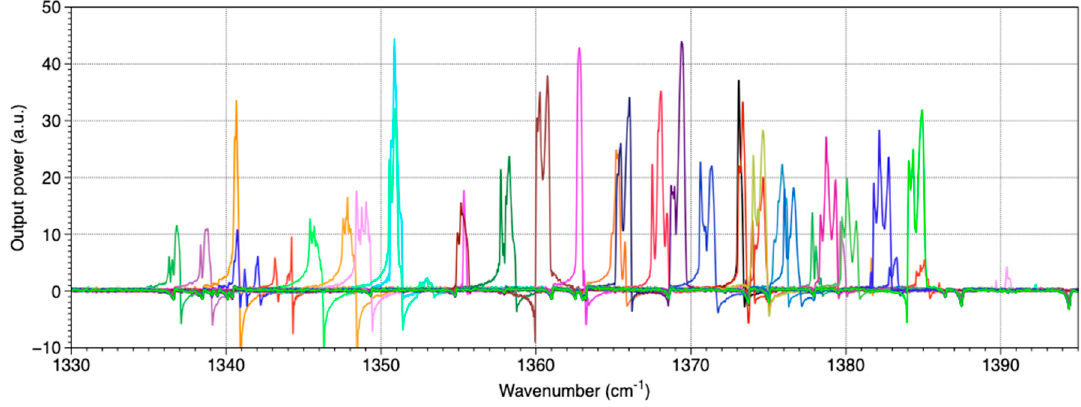
Figure 4. Emission spectra of all the QCLs from the DFB QCL array for one temperature (20 °C).